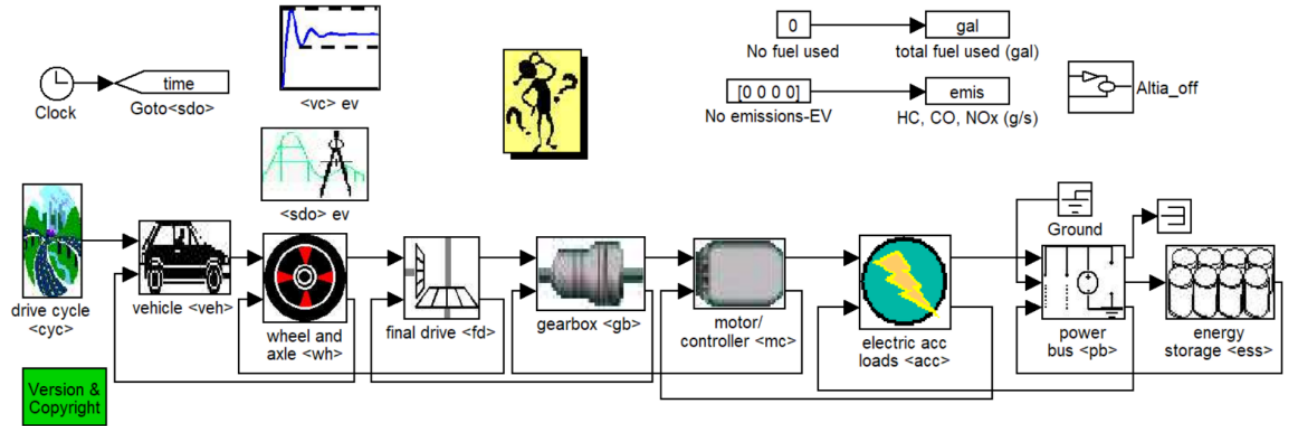
Figure 2. Top-level module of vehicle model simulation.